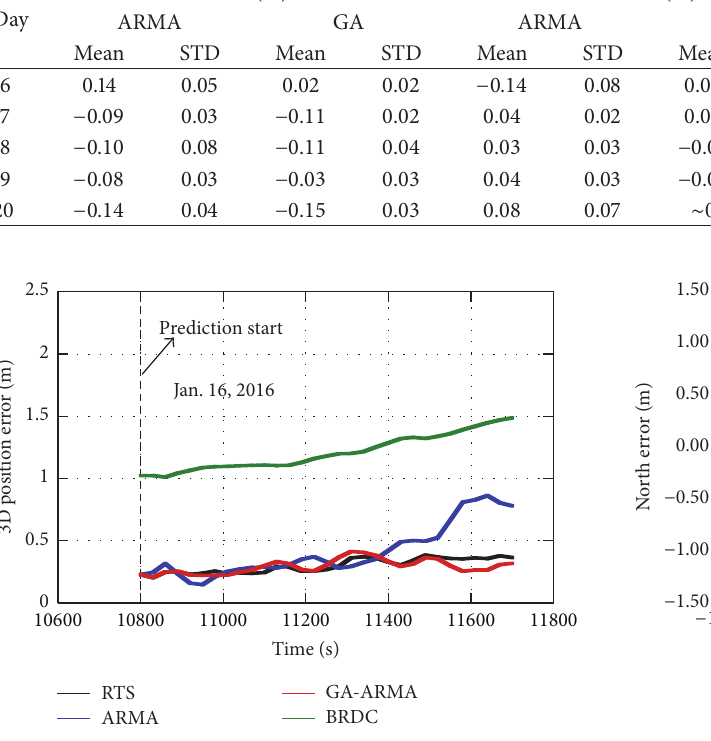
Figure 7: User positioning errors by using predicted corrections (January 16, 2016).